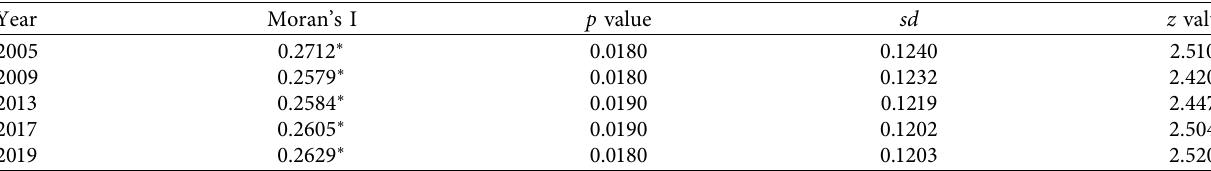
Table 2: Moran’s I statistics of China’s